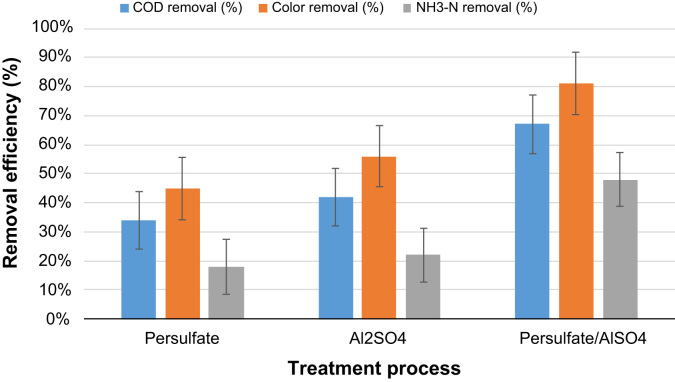
Comparison the performance of persulfate, Al2SO4 and combined persulfate/Al2SO4 for COD , color and NH3–N removal.